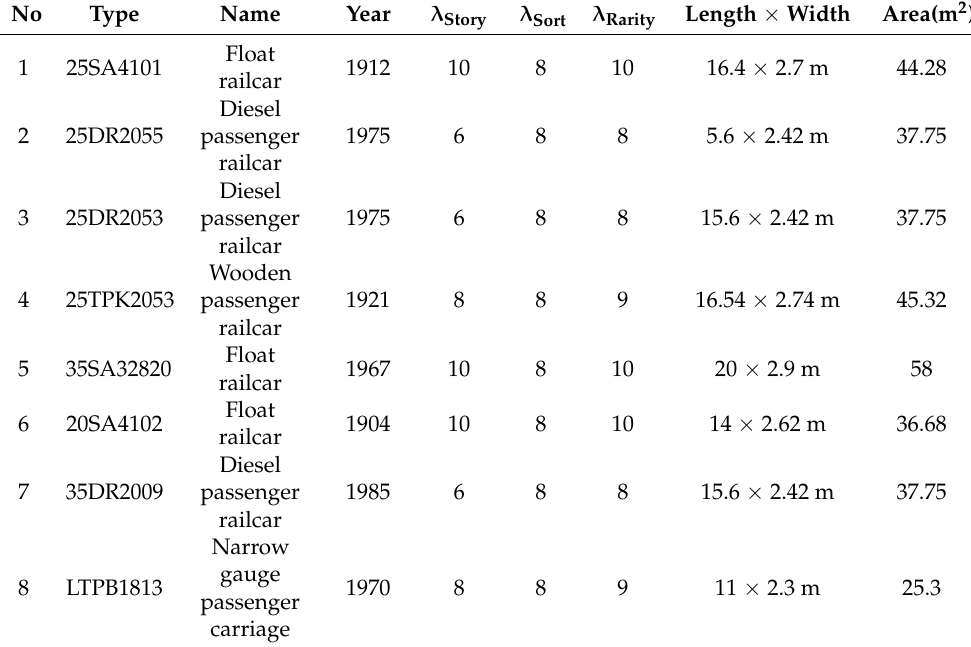
Table 9. After mutation of the layout instance (optimal chromosomes).